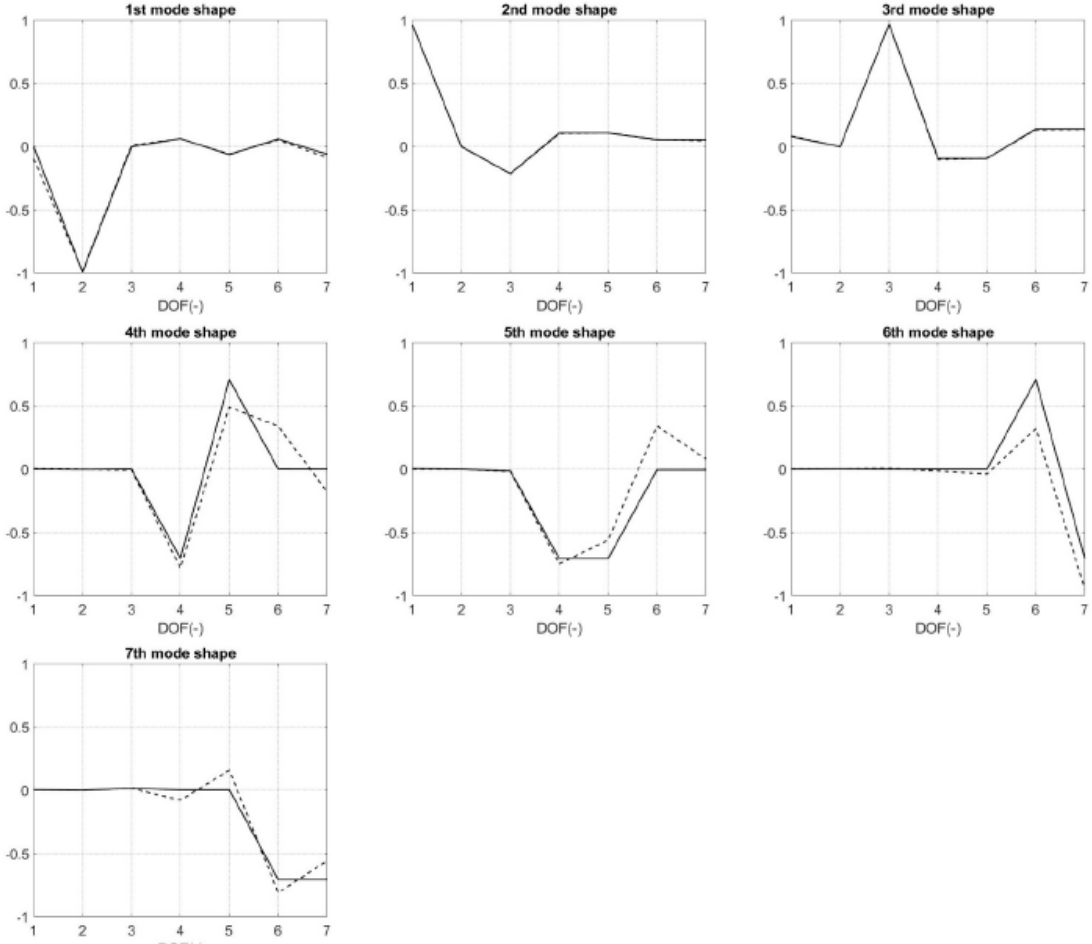
Figure 13. Mode shapes of seven-DOF car model (the solid line is an analytic solution, the dotted line is ERA/DC identification result).